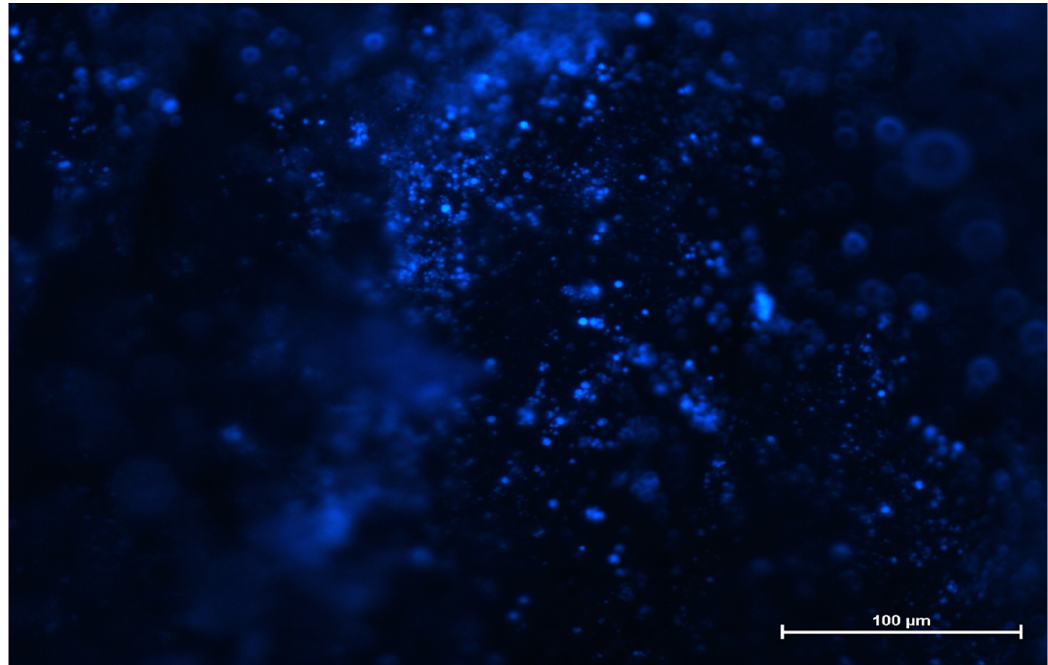
Figure 6. The preparation of rat iliac vein. PLA-DH microspheres visible in the vessel after iv administration. Fluorescence microscopy images (Nikon Eclipse TE 2000-S, Akishima, Japan), 200× magnification.